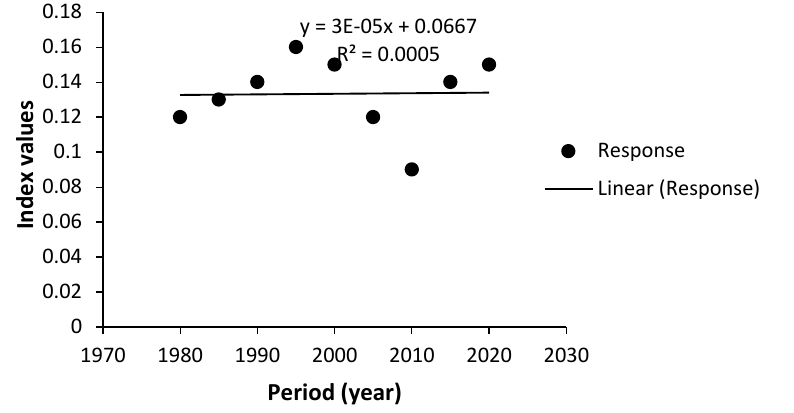
Figure 8-Inter-annual variation of the state and impact index.